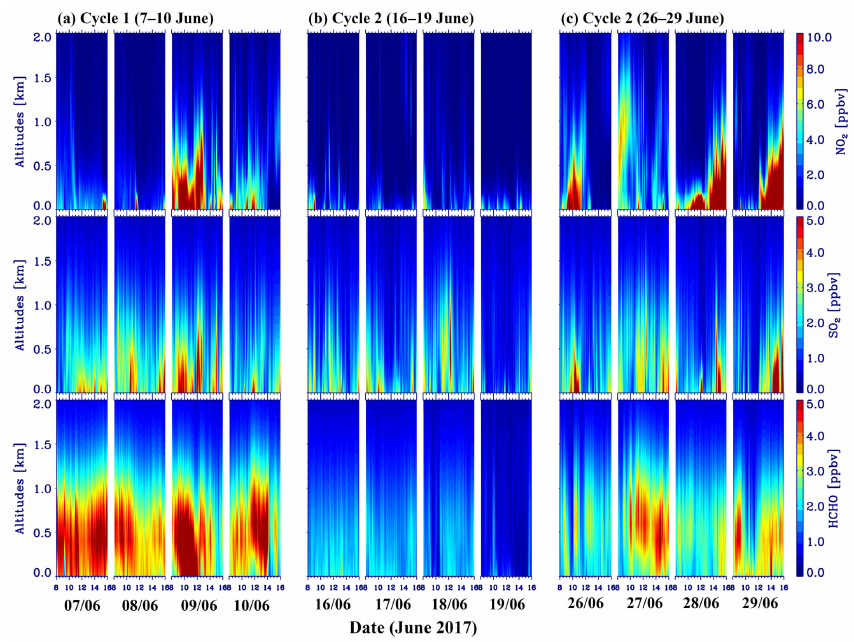
Figure 12. Vertical profiles of NO 2 , SO 2 , and HCHO concentrations during the three typical observation periods: (a) measurements taken at Hangzhou Bay and the Zhoushan Islands from 7 to 10 June, (b) measurements carried out at a relatively clean area from 16 to 19 June, and (c) measurements implemented in the area of the Yangtze River estuary on 26 to 29